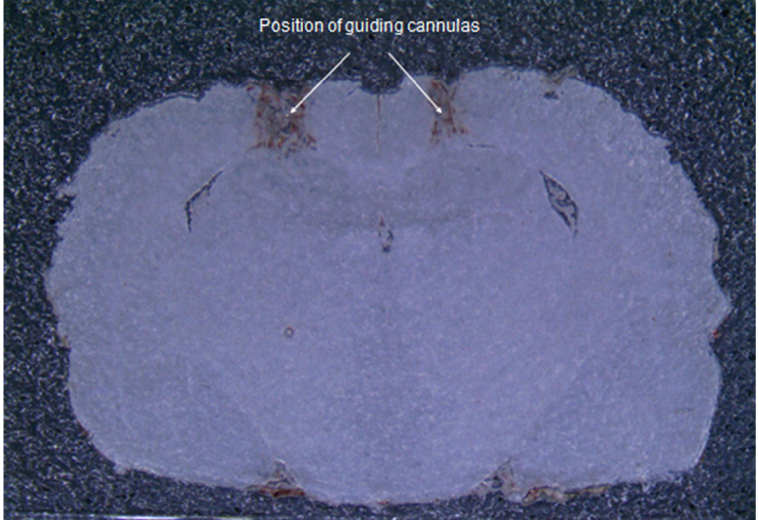
Figure 1. Frontal section of the brain. A photograph of a brain slice of an operated rat demonstrates the correspondence of insertion sites of guide cannulas to the selected coordinates.